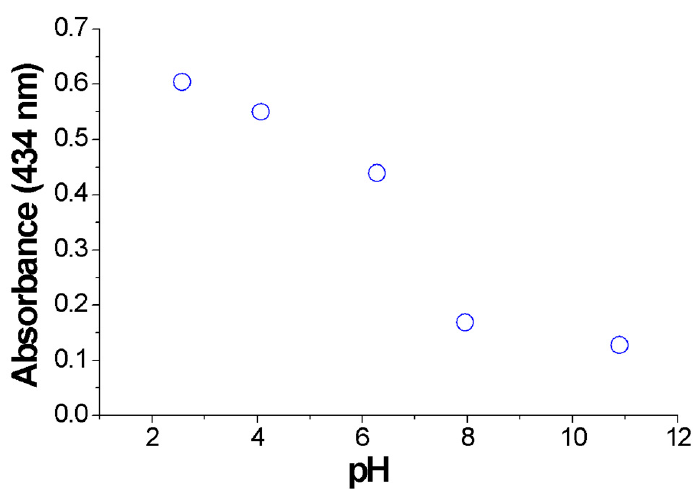
Figure 6. Absorbance variation at 434 nm of the colloids (PKHEDA 1 × 10 − 4 M / TPPS 5 × 10 − 5 M) as a function of